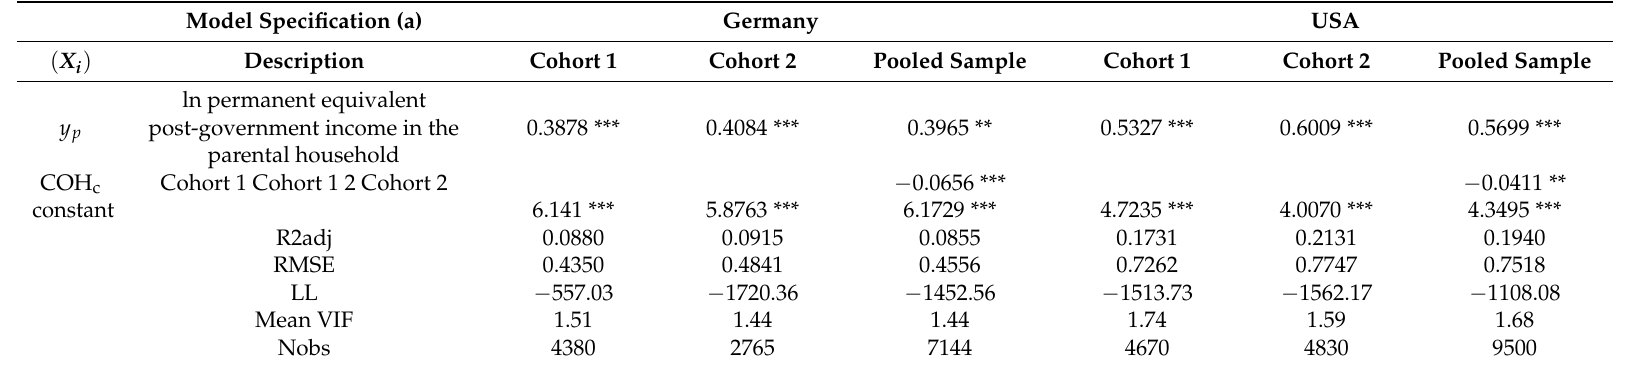
Table 4. Intergenerational income mobility.